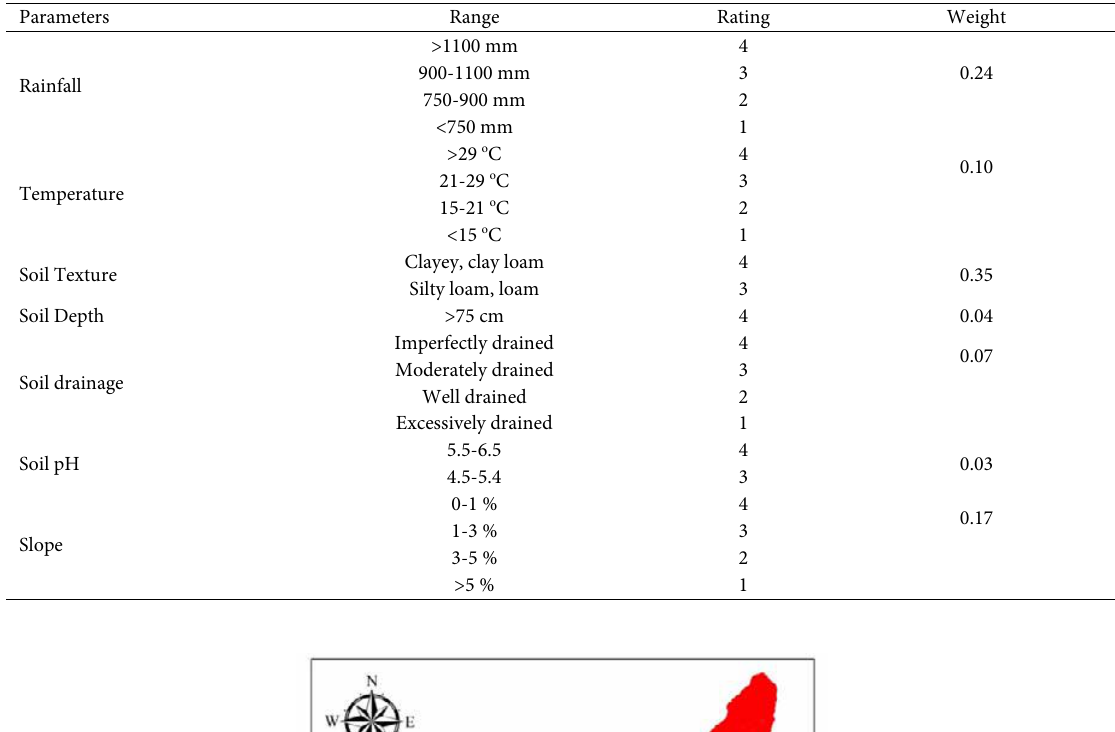
Table 6: Parameters with its assigned rates and their corresponding weights